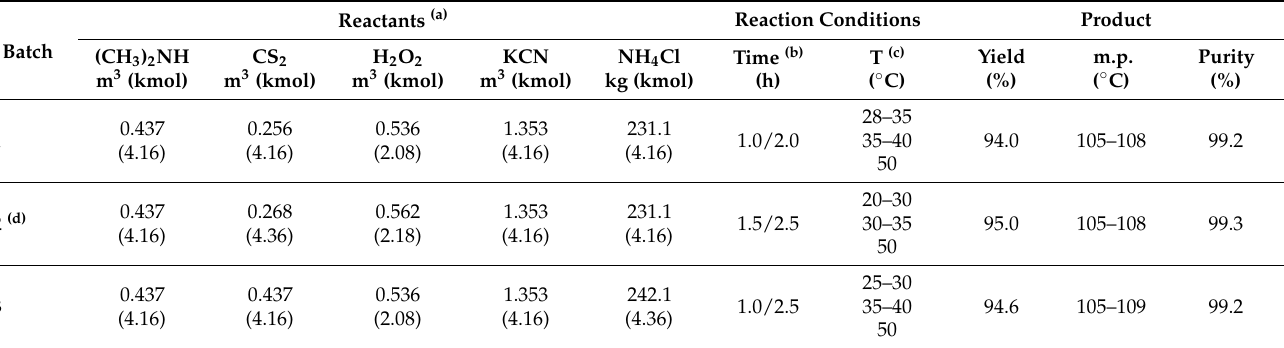
Table 6. The results of the semi-industrial synthesis of TMTS.